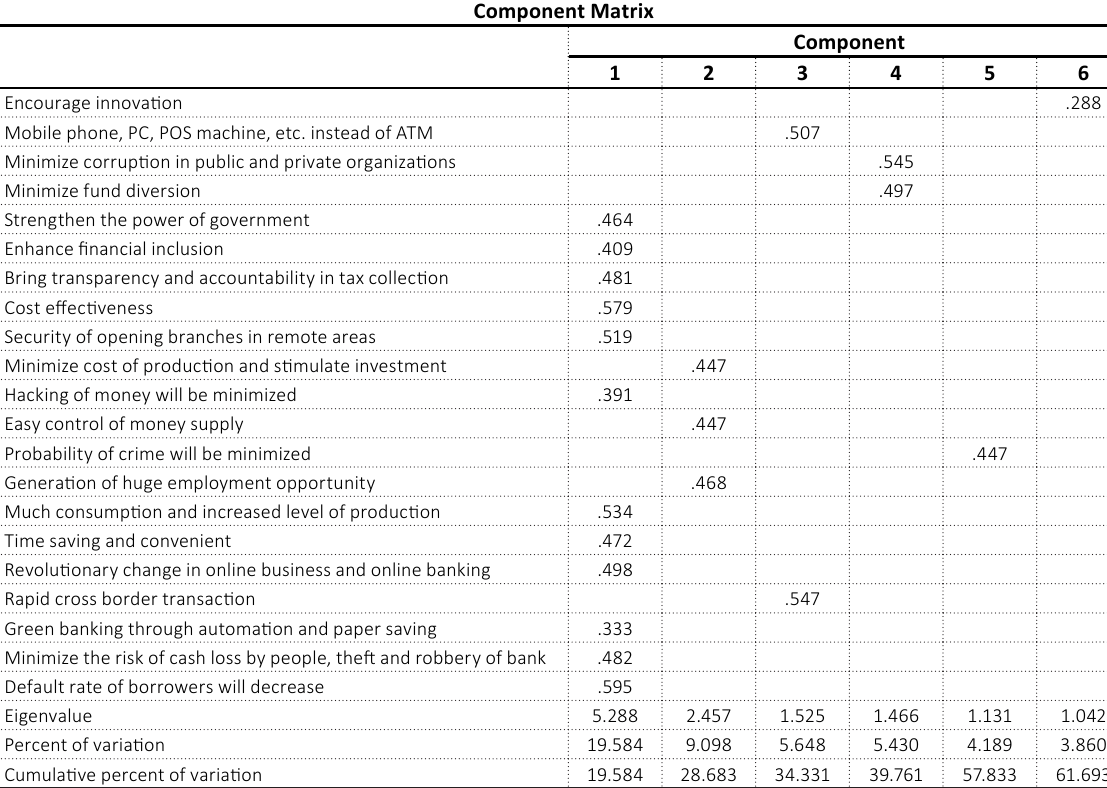
Source: Field Survey (2016, August).